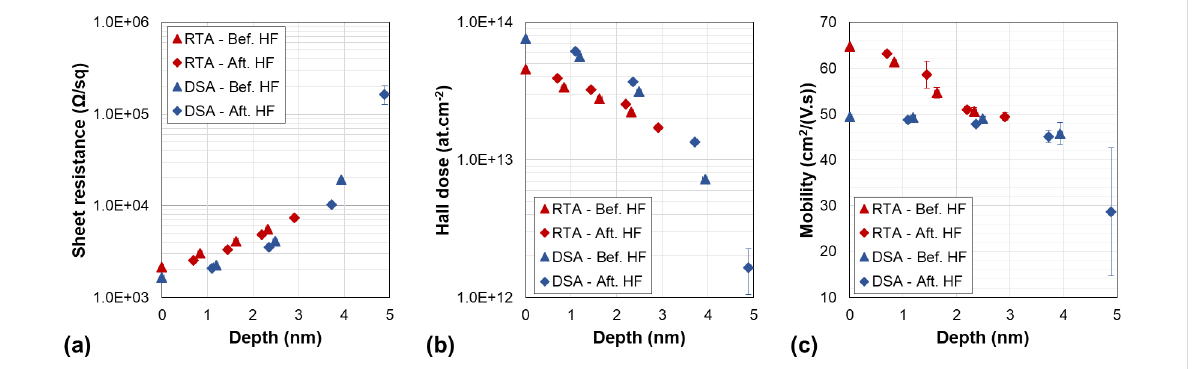
Figure 9: Hall effect measurements (raw data: (a) R S , (b) N H and (c) µ H ) of the SOI samples implanted with arsenic and annealed with DSA (red symbols) and RTA at 1050 °C (blue symbols), as a function of the etched thickness (as measured by ellipsometry).